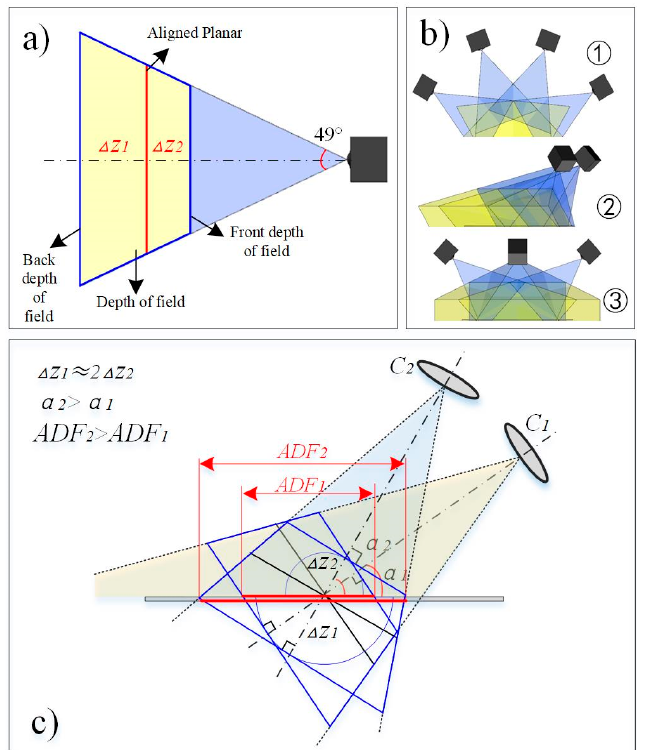
Figure 4. Relationship between camera depth of field and remaining work planes ( a ) Depth of camera area; ( b ) Depth of field area in the form of three camera layouts; ( c ) With the same depth of field, the intersection of the field of view of two cameras with different pitch angles and the working plane.